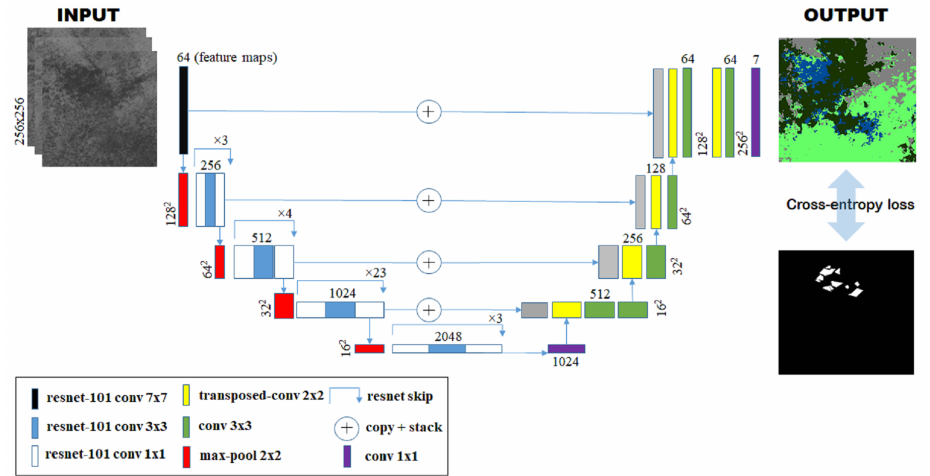
Figure 4. U-Net architecture and loss calculation. The input channels are stacked and passed through the network. The encoder network applies repeated convolution and max pooling operations to extract feature maps, while in the decoder network upsamples these and stacks features from the corresponding layer in the encoder path. The output is a segmented map, which is compared with the mask using crossentropy loss. The computed loss is used to train the network, through gradient descent